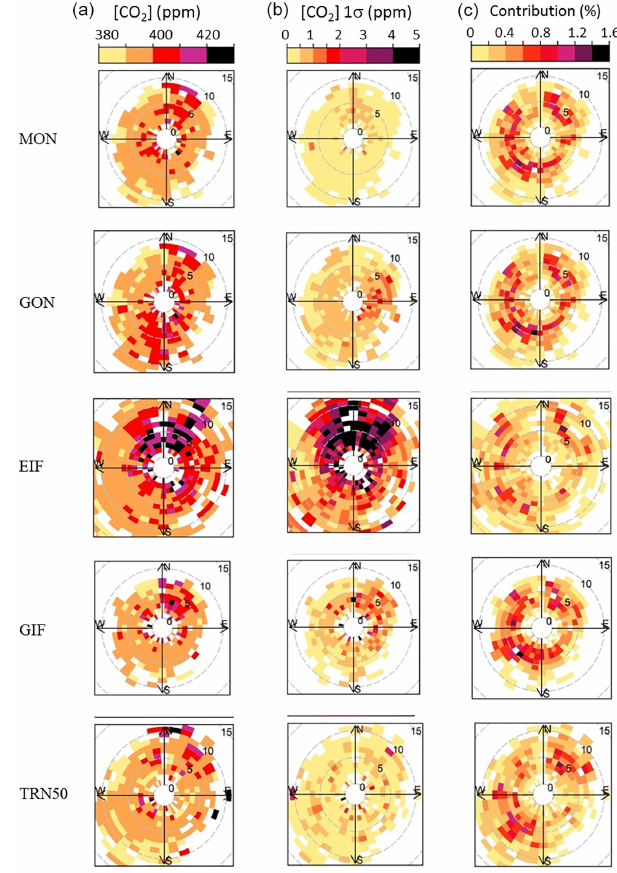
Figure 11. (a) CO 2 mean concentration as a function of wind speed (circles in ms − 1 ) and wind direction at MON (NE rural), GON (NE peri-urban), EIF (urban), GIF (SW peri-urban) and TRN50 (rural) stations using daytime data (11:00–15:00UTC) for the period of study (4 August 2010–11 July 2011). (b) Mean 1 σ CO 2 variability of each concentration (ws, wd) point. (c) Occurrence as the fre- quency of the (ws, wd) bin weighted by the square root of the CO 2 concentration